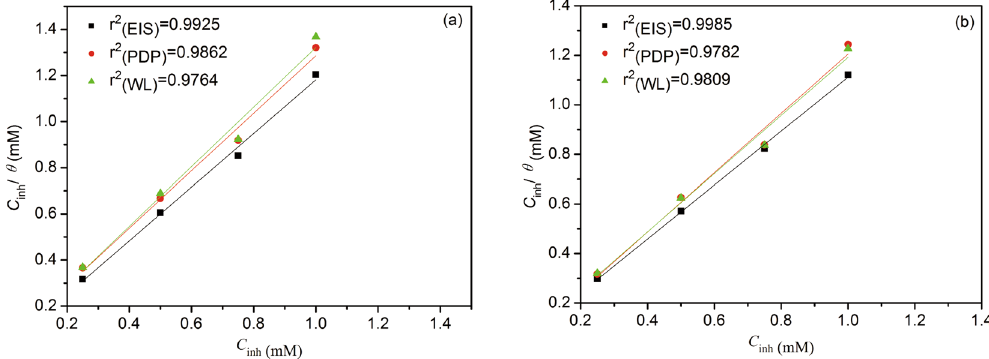
Figure 8. Langmuir isotherm for carbon steel in 0.5 M HCl solution with different concentrations of BAIL1 ( a ) and BAIL2 ( b ) calculated by EIS ( ), PDP ( ) and WL ( ) results.